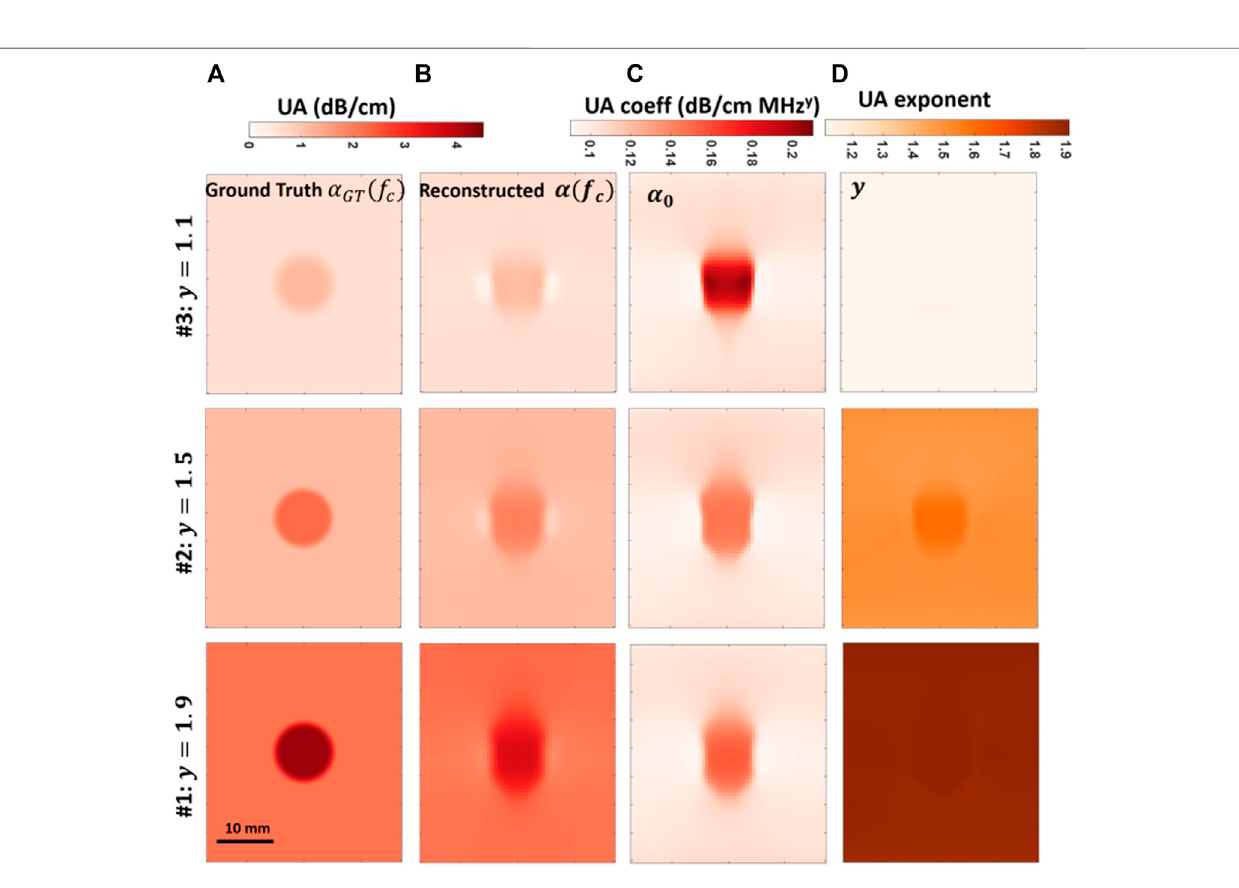
Frontiers in Physics |